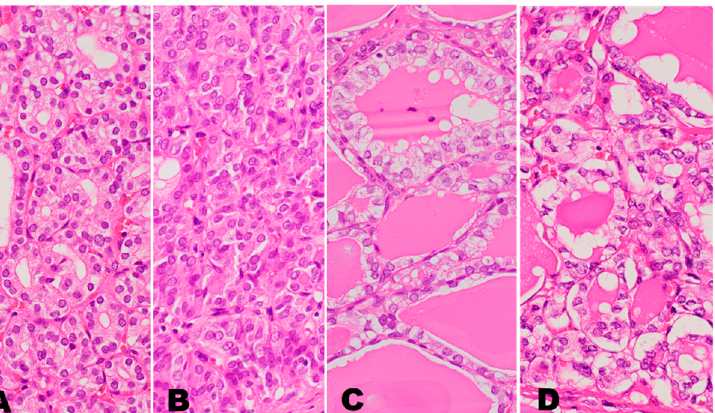
Figure 1. Nuclear features of encapsulated follicular pattern tumors. ( A ): nuclear score 0 in a follic- ular adenoma, ( B ): nuclear score 2 in a NIFTP (nuclear enlargement 1, membrane irregularity 1 and chromatin clearing 0), ( C ): nuclear score 3 (nuclear enlargement 1, membrane irregularity 1,